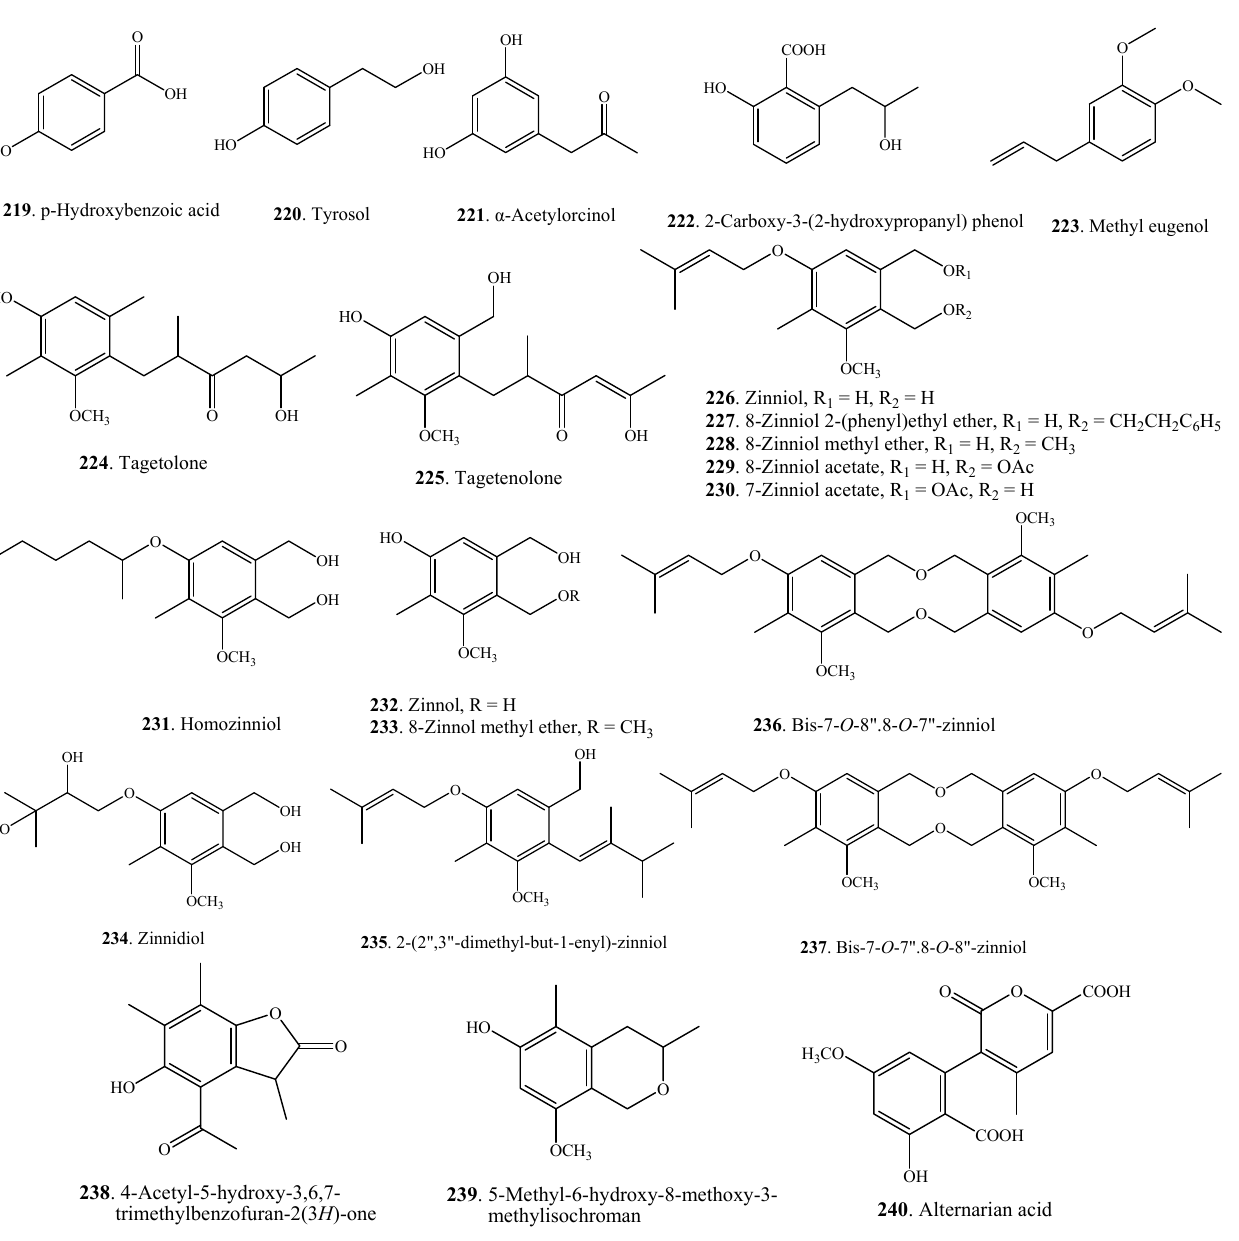
Figure 12. Phenolic metabolites isolated from Alternaria